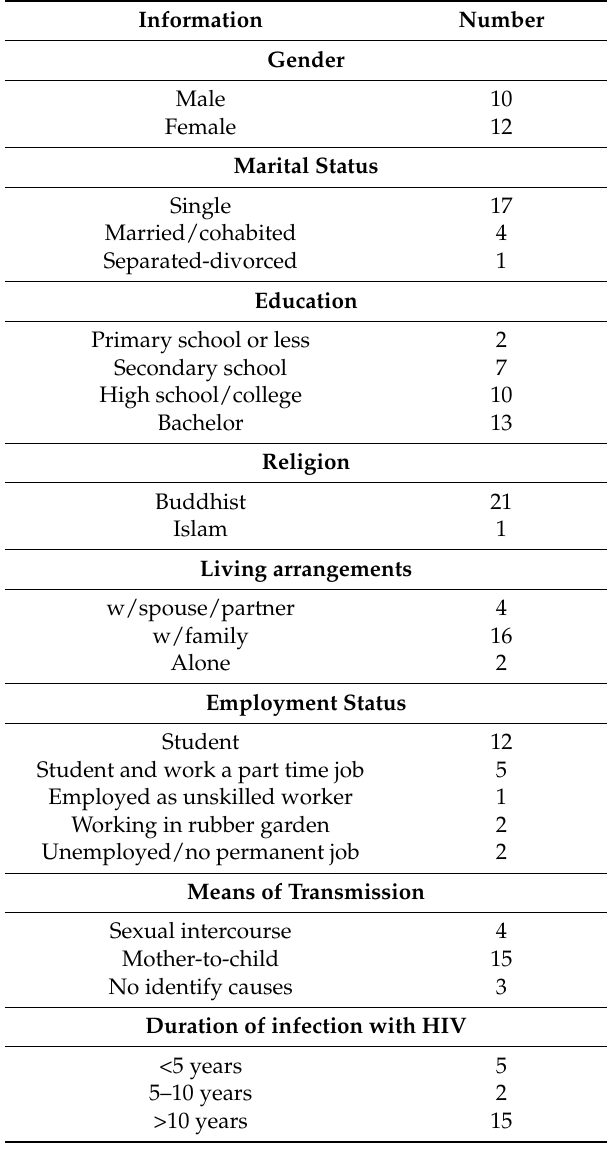
Table 1. Participant Demographics ( n =